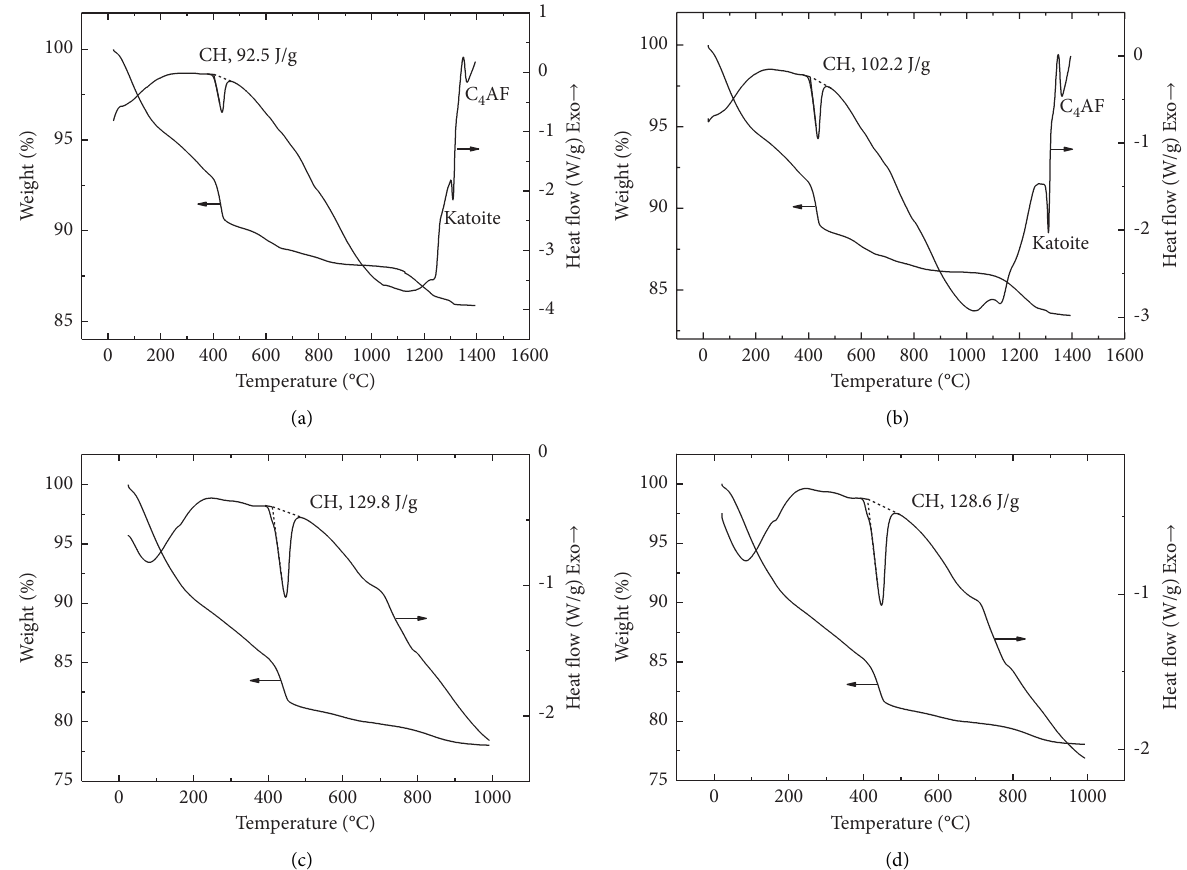
Figure 4: The TG-DSC curves of specimens: (a) inner part at 6 hours; (b) outer part at 6 hours; (c) inner part at 120 days; (d) outer part at 120 days. Table 6: The content of chemically bonded water and calcium hydroxide. Inner part Outer part Chemically bonded water